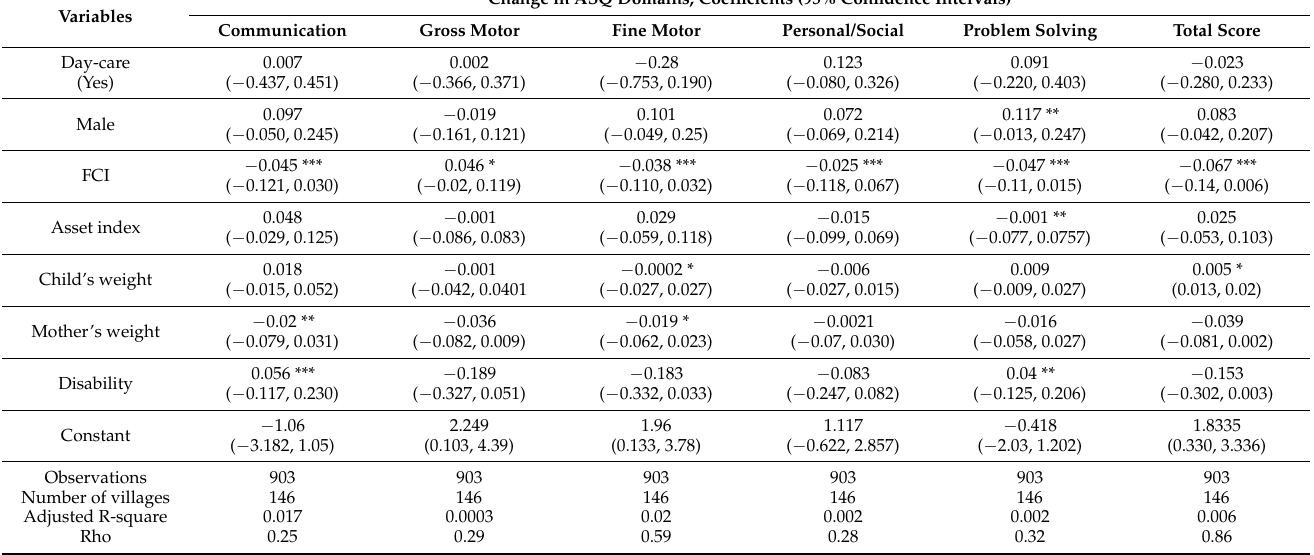
Table 4. Coefficient estimates from multivariable linear regression models and regression differences in the ASQ z-scores in round one and round two on individual and household characteristics as well as differences in exposure to solid